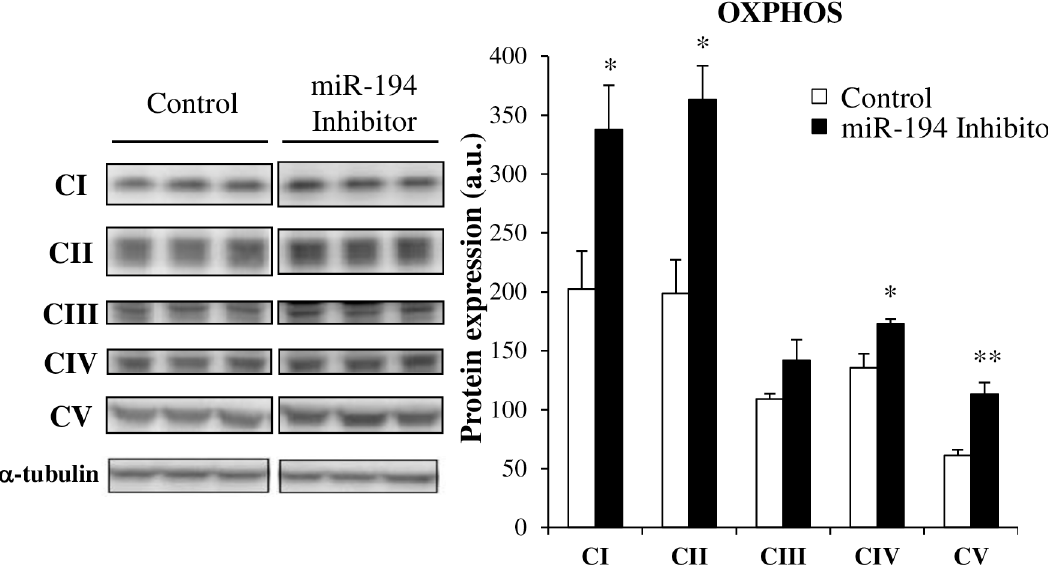
Fig 5. Effect of miR-194 inhibition on protein expression of the oxidative phosphorylation complexes expression in L6 cells. Expression of the oxidative phosphorylation (OXPHOS) complexes I to V of the electron transport chain was measured by western blot in L6 cells 48 hours after transfection with a miR-194 inhibitor. Data are expressed as mean ± SEM (n = 3 per group). Representative blots are shown. P -values were determined using t- tests ( * p < 0.05 and ** p < 0.01 vs